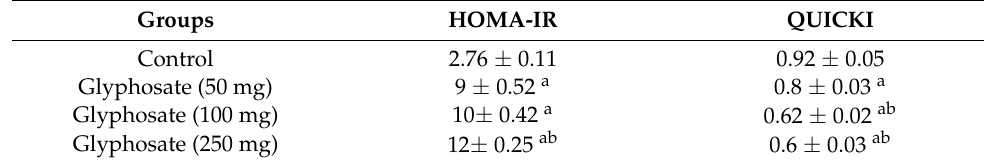
Table 4. Levels of HOMA-IR and QUICKI in glyphosate explore diabetic